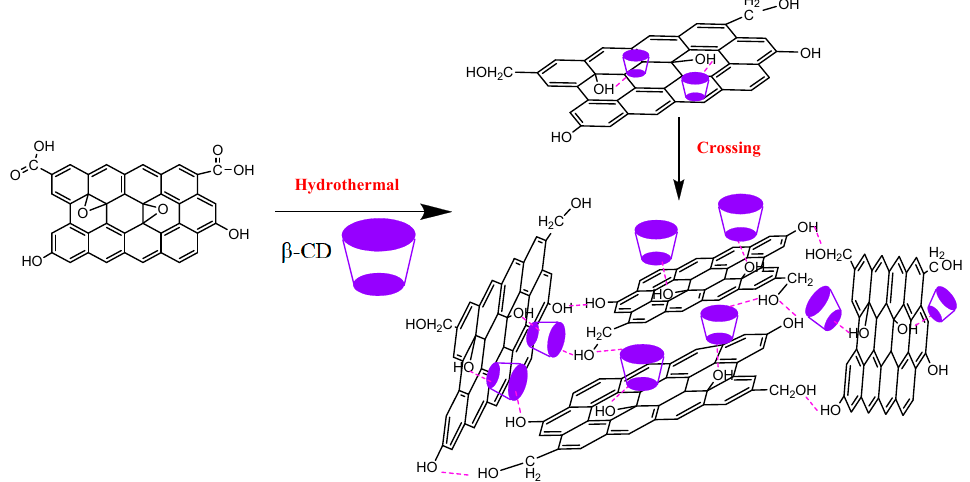
Figure 7. Working mechanism of hydrothermal reduction and